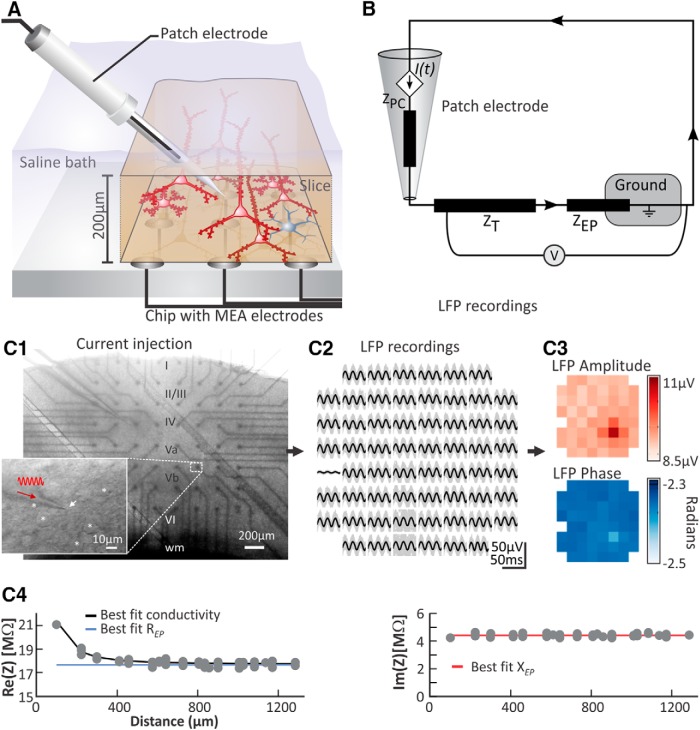
Experimental setup. A, Current was injected by a patch electrode into the extracellular medium of a 200-µm-thick thalamocortical slice preparation immersed in ACSF (excitatory cells are represented in red, and inhibitory cells in gray). The extracellular potential was measured simultaneously by all electrodes of the MEA beneath. B, The recording setup can be represented as an equivalent circuit where current flows from the patch-clamp electrode toward the ground, while the electric potential is recorded by a voltmeter. ZPC, Patch-clamp impedance; ZT, tissue impedance; V, voltmeter (MEA electrodes); ZEP, electrode polarization impedance. C, Schematic overview of the recording and analysis routine. C1, Picture photograph of the acute brain slice preparation during the current injection and LFP recording. Roman numbers indicate the position of layers I to VI of the somatosensory cortex. wm, White matter. Enlarged section zooming in on layer Vb shows neuron somata (asterisks), the positioning of the tip of the patch pipette (white arrow) and an illustration of the injection of sinusoidal current (red) into the cortical tissue. C2, LFP recording via the MEA. The array shows for each electrode the 50 recorded sweeps (gray) and, superimposed, the average LFP (black). C3, The LFP amplitude and phase at a given current injection frequency was extracted from the averaged LFPs using a Fast Fourier Transformation. The largest LFP amplitude was detected at the MEA electrode directly underneath the tip of the patch pipette. C4, With the amplitude and phase of the LFP and injected current, we can find the total impedance, Z(r) = ZT(r) + ZEP = φ0(r)/I0 e(j
(β(r)-
α)) (Eq. 8). The real part of Z (Re(Z); C4, left) shows a decay with distance toward a constant, from which we can find the tissue conductivity (black line, Eq. 2) and REP (blue line). The imaginary part of Z is constant (C4, right), implying Im(Z) ∼ XEP (red line), and Im(ZT) ∼ 0.